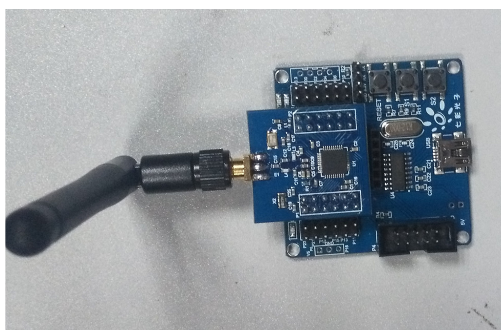
Figure 8. An electromagnetic signal source.